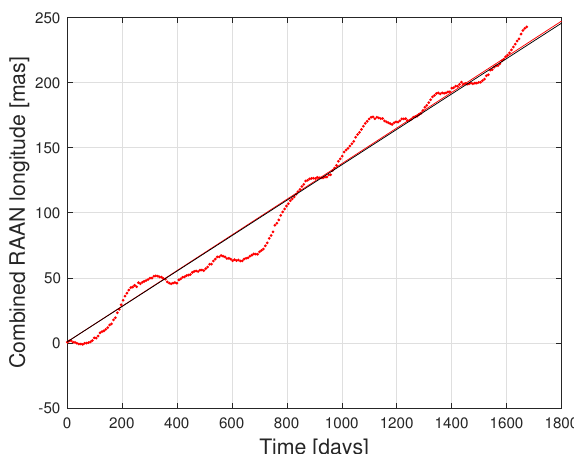
Figure 15. Combined residuals (red dots) of the RAAN longitude of LAGEOS, LAGEOS II and LARES. The continuous red line represents a linear fit to these combined residuals. The continuous black line represents the corresponding prediction of GR for the Lense-Thirring